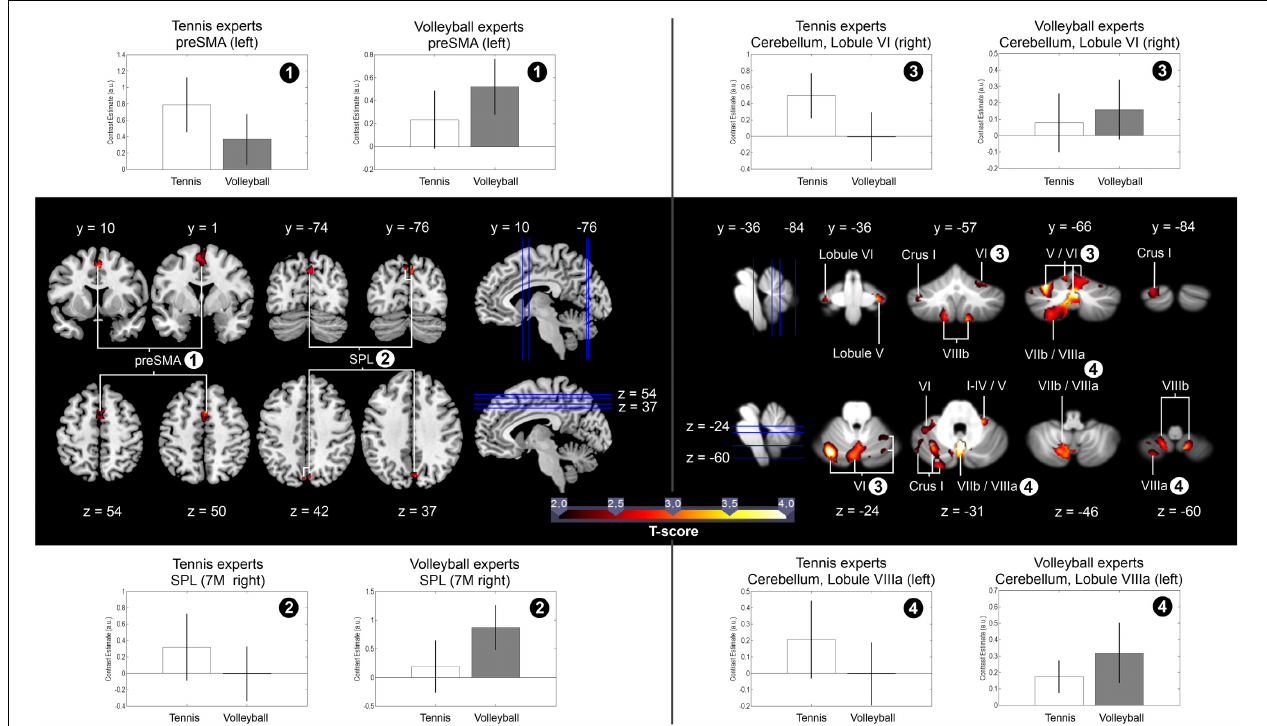
FIGURE 3 | In the middle of the figure: Significant brain activation in all 31 participants for the contrast ( Expertise Anticipation > Expertise Observation ) > ( Novice Anticipation > Novice Observation ). The blue vertical and horizontal lines indicate the slice positions. T maps were thresholded at t = 2 . 00 ( p < 0 . 05, FWE-corrected). Activation is rendered on a high-resolution T1 template (“colin brain”) as well as on the cerebellar SUIT